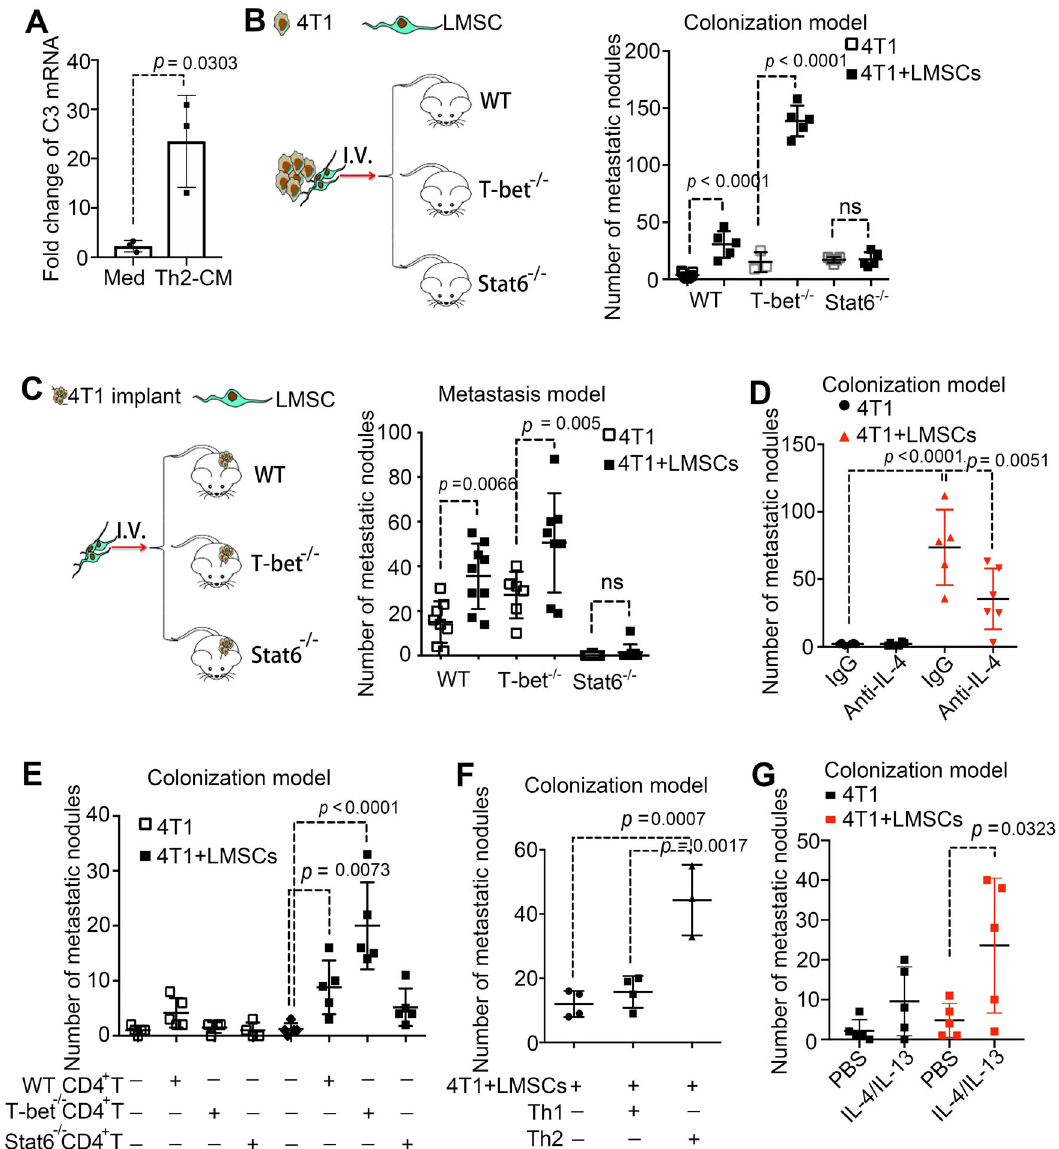
CD4 + T cells were induced into Th2 cells, which were then cultured in fresh medium for 12 h, to generate Th2-CM. LMSCs were treated